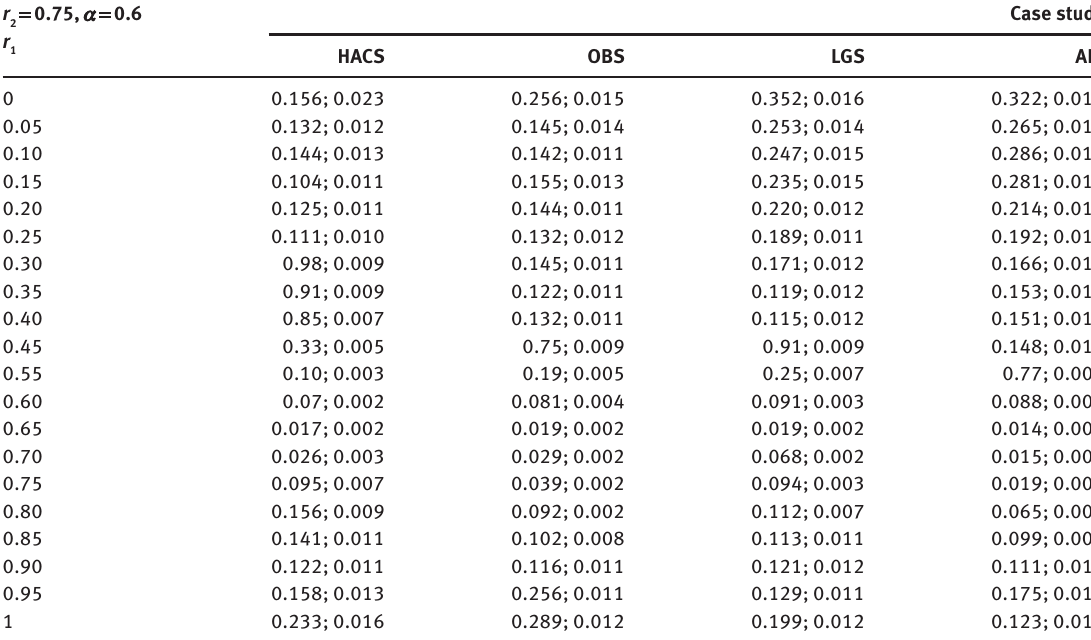
Parameter on the DBI Criterion Using the Four Cases (Average of 30 Runs). Table 2: Effects of r 1 = 0.75, α = r 2